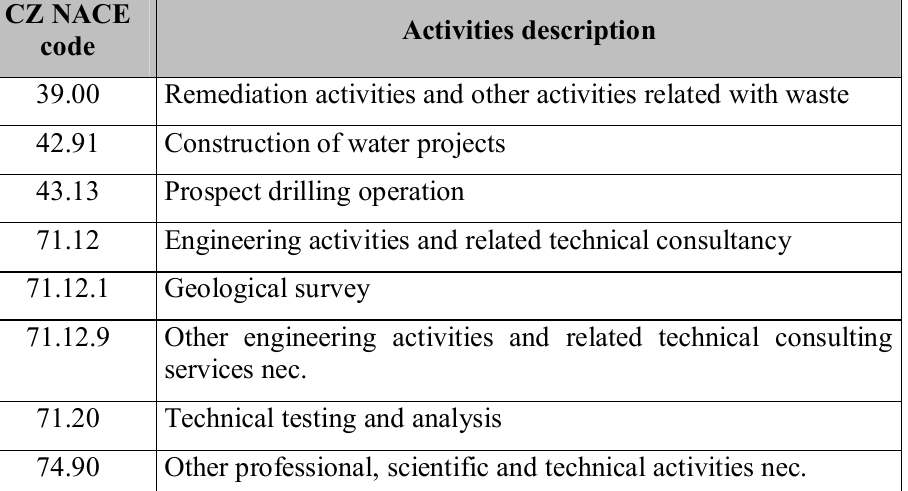
Table 3 - Description of the activities according to